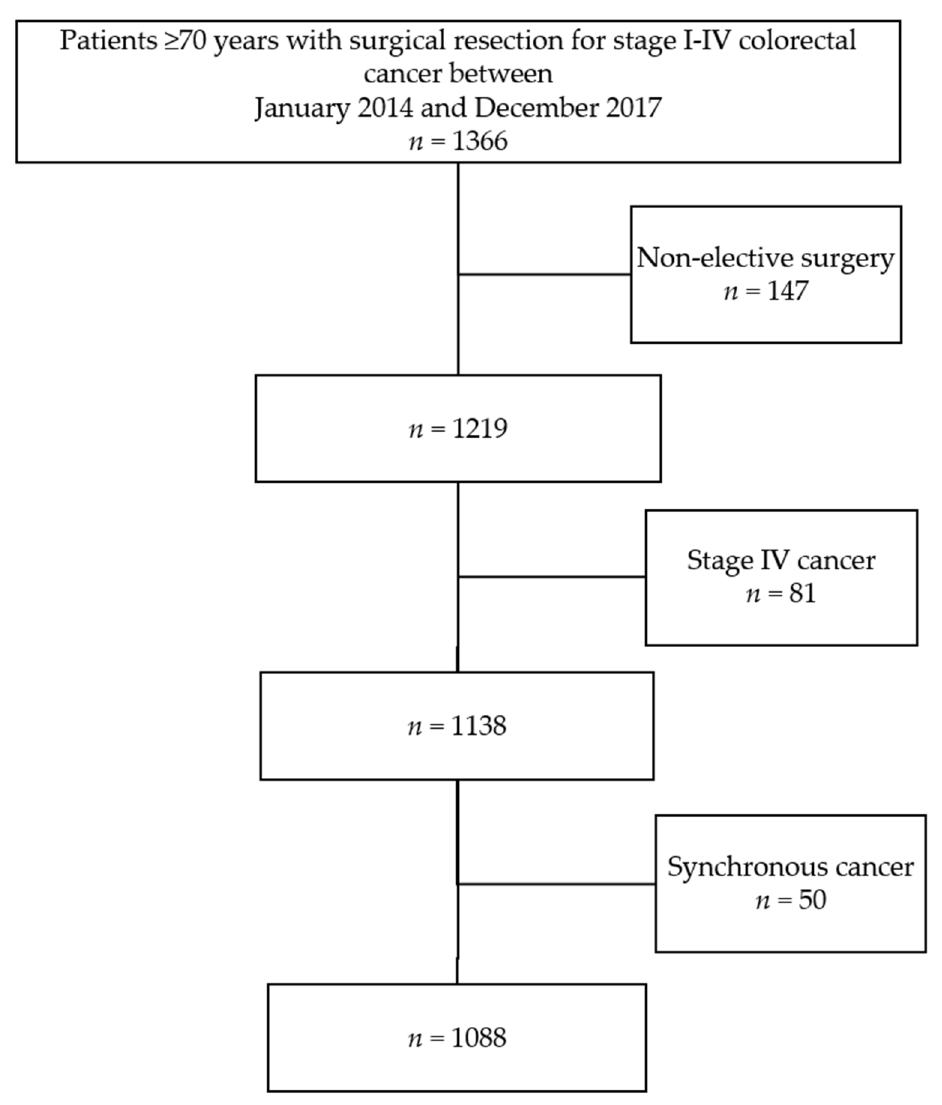
Figure 1. Patient selection .